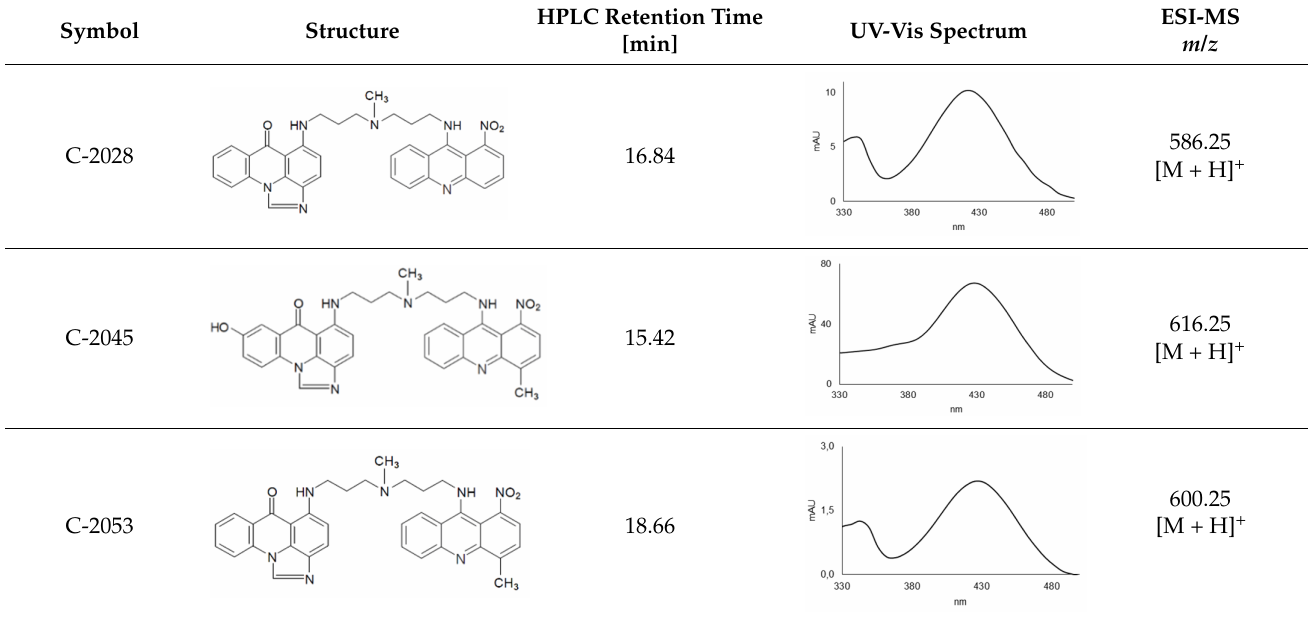
Table 1. Chemical structures and individual background properties of the UAs